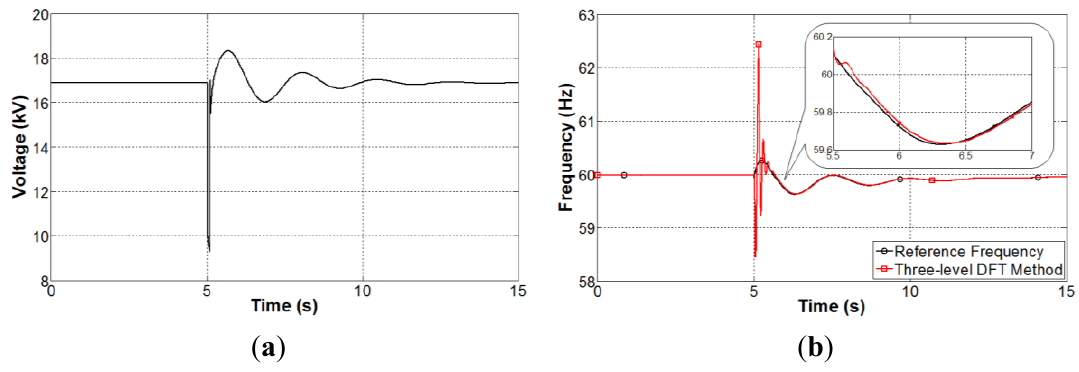
Figure 11. Estimation of the power system frequency when a single line-to-ground 90° fault occurred. ( a ) Terminal voltage of generator A; ( b ) Estimated frequency.